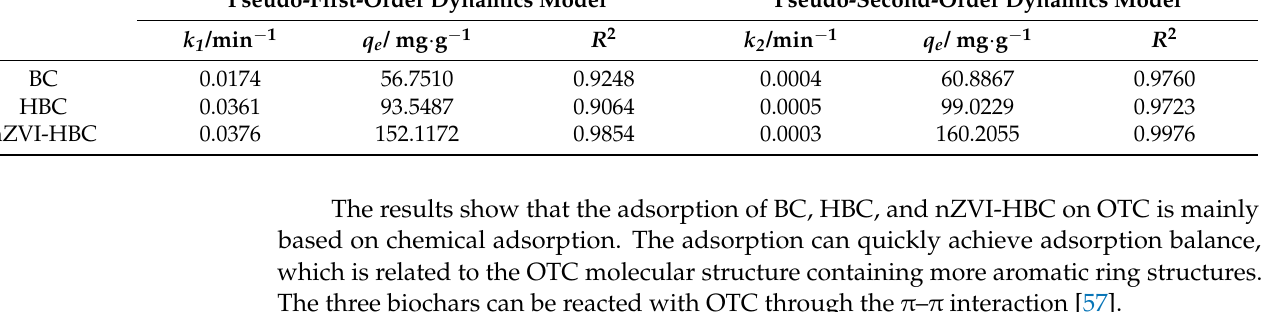
Figure 12. Degradation pathway of OTC.